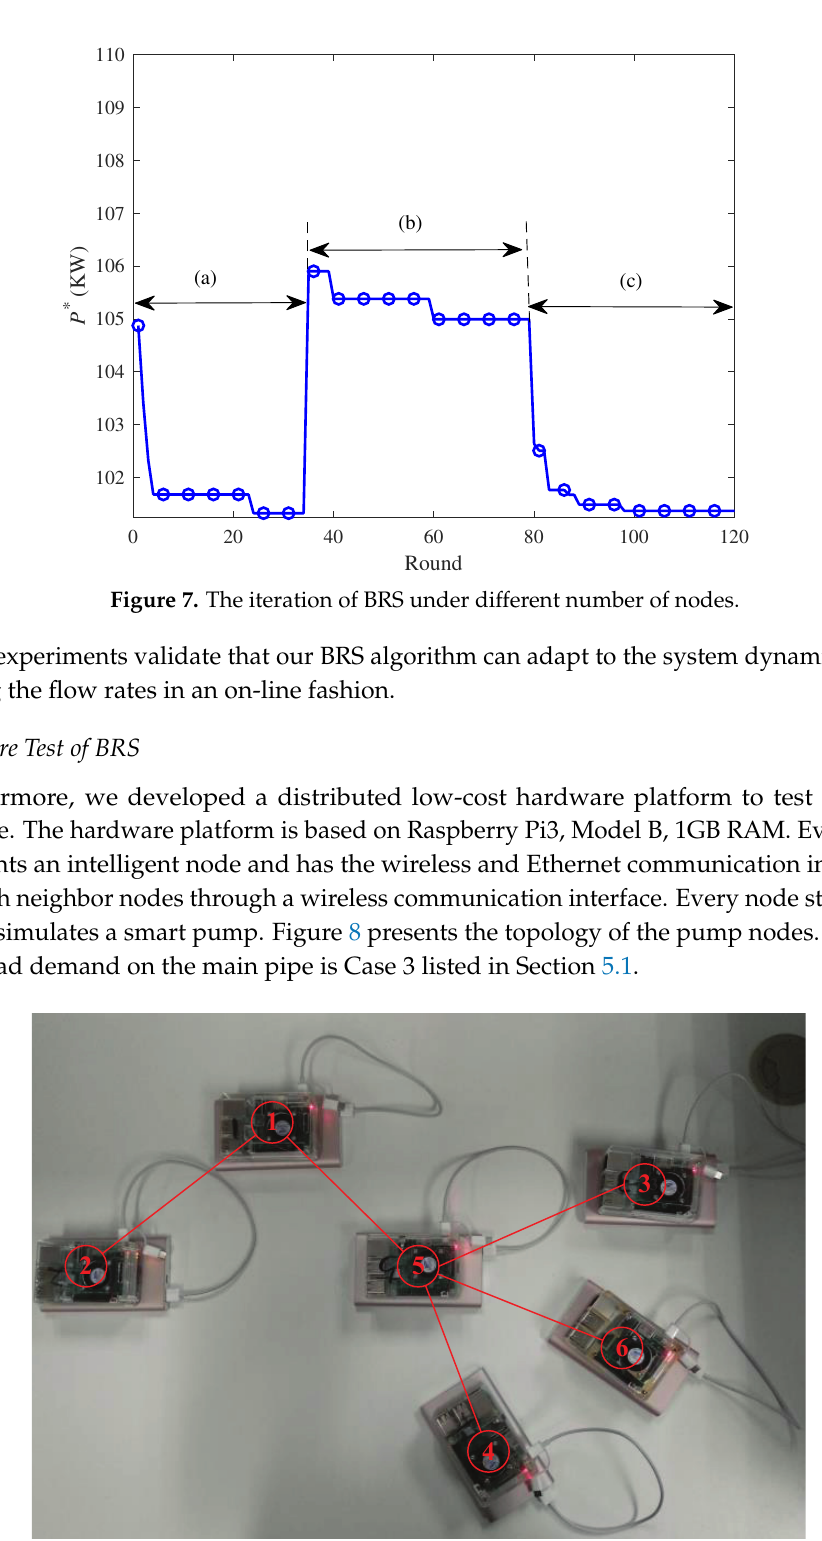
Figure 8. The hardware platform for test distributed